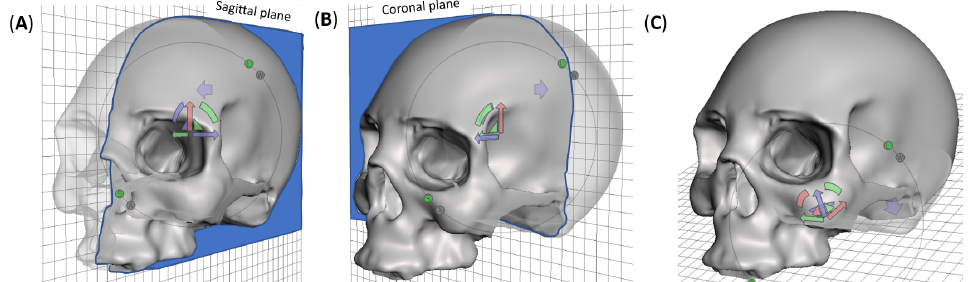
Figure 1. Digital sectioning strategies for additive manufacturing and mechanical characterization of the skull surrogate, showing ( A ) sagittal cut, which yields symmetrical left-right hemi-skulls, ( B ) coronal cut, which splits the skull in frontal and occipital hemi-skulls, and ( C ) whole skull, presenting an opening in the base of the occipital